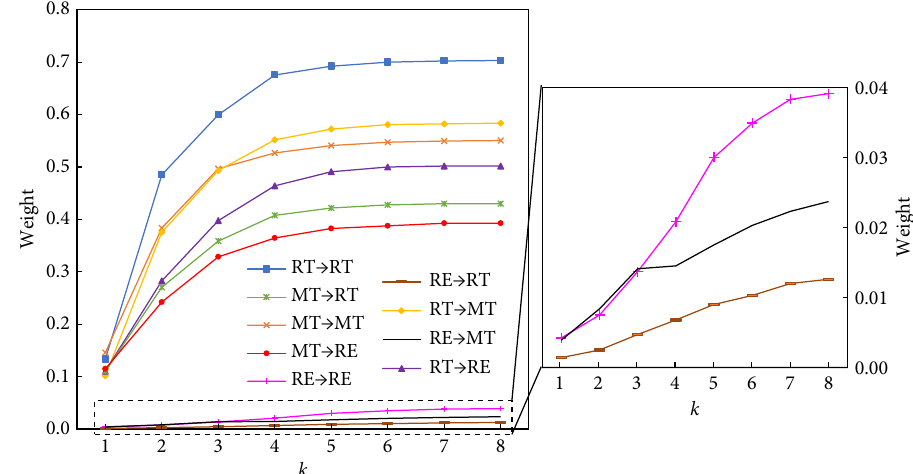
Fig. 6 Experimental result on the Twitter dataset. The figure on the right is a partial enlargement of the figure on the left.